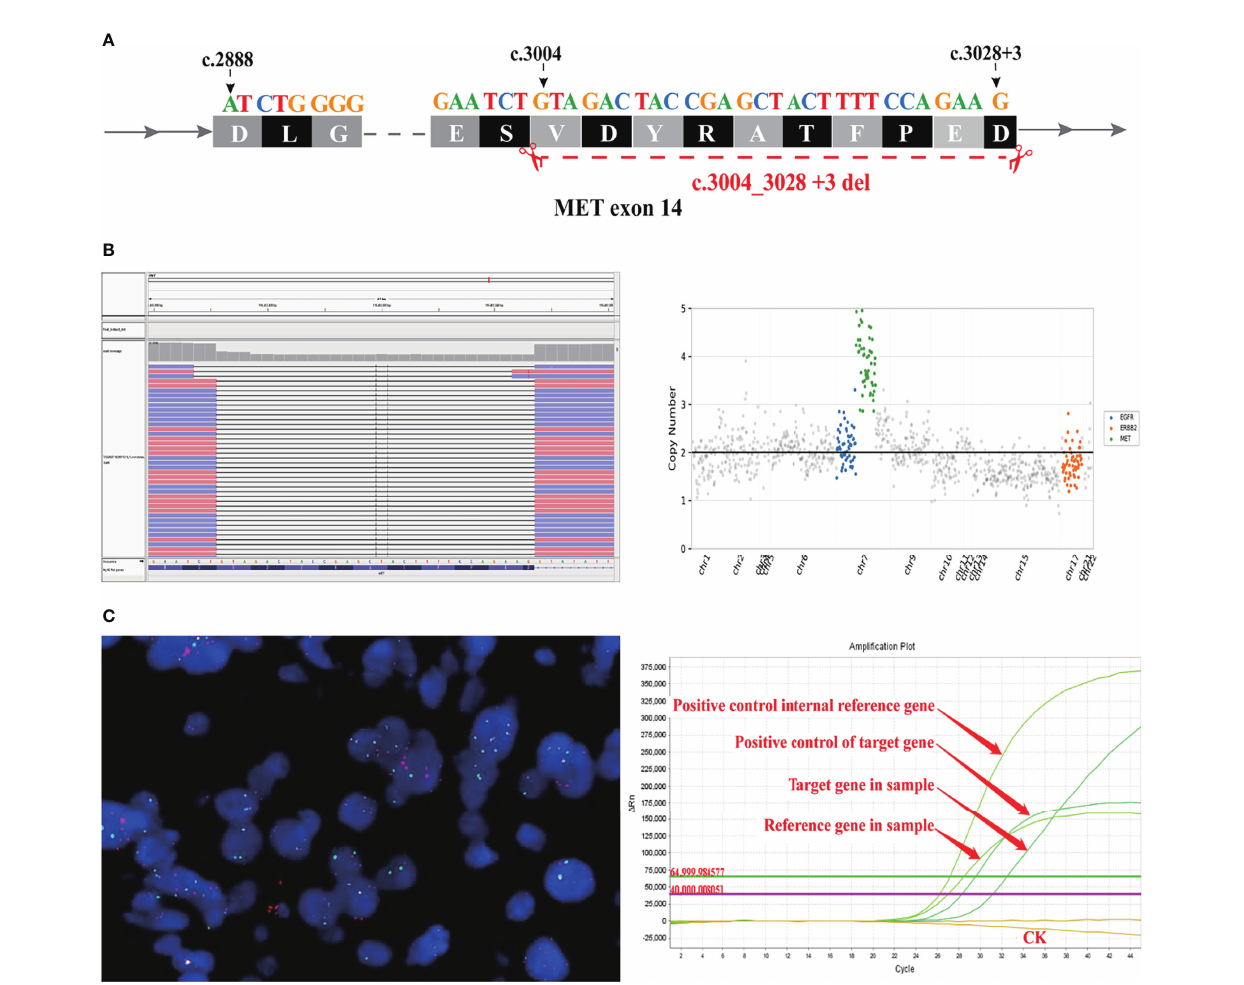
FIGURE 3 | A novel MET exon 14 skipping variant concomitant MET ampli fi cation was discovered in a patient with lung adenocarcinoma. (A) Illustration of METex14 variant. (B) Sequencing reads of MET is shown by the Integrative Genomics Viewer. (C) CytoTest MET/CCP7 FISH Probe results showed MET ampli fi cation positive (left panel) and qPCR ampli fi cation melt curve based ABI7500 (right